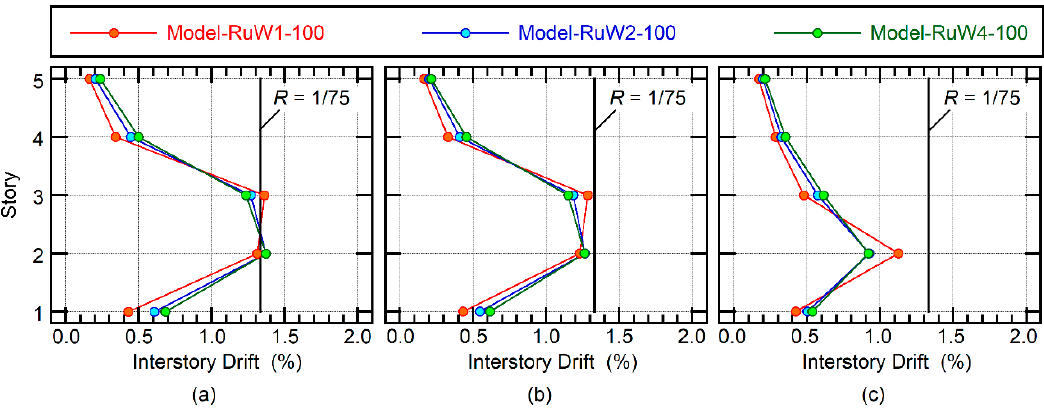
Figure 27. Comparison of the peak drift for columns ( λ = C I, bi ) for Models RuW1-100, RuW2-100, and RuW4-100: ( a ) column A 1 B 1 , ( b ) column A 3 B 1 , and ( c ) column A 3 B 3 .